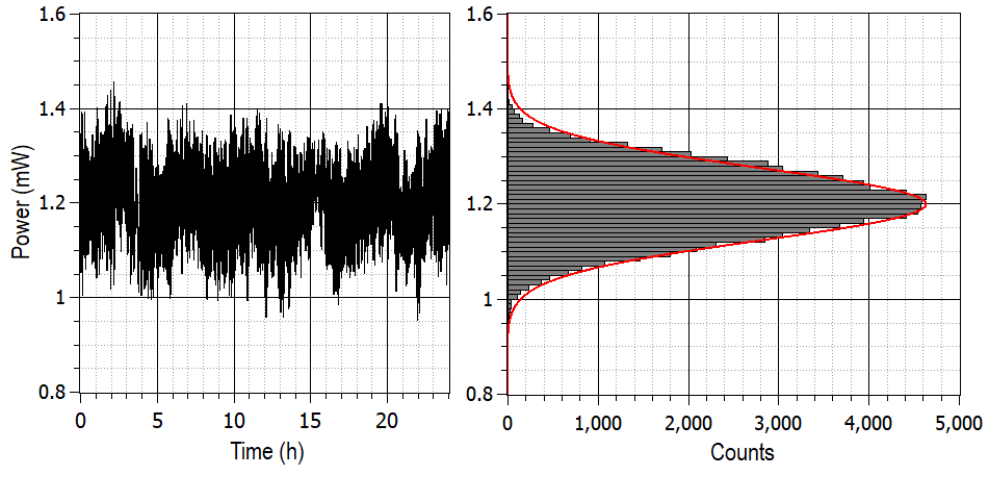
Figure 4. Power fluctuations at the output of a fibered polarizer placed after the 3 km-long telecom fiber. Left: Power measured at the output of the fibered polarizer for 8 mW linearly polarized light injected at the input of the telecom fiber. Right: Statistical distribution of this power and its gaussian fit. The average is 1.2 mW, FWHM is 0.152 mW, and R 2 is